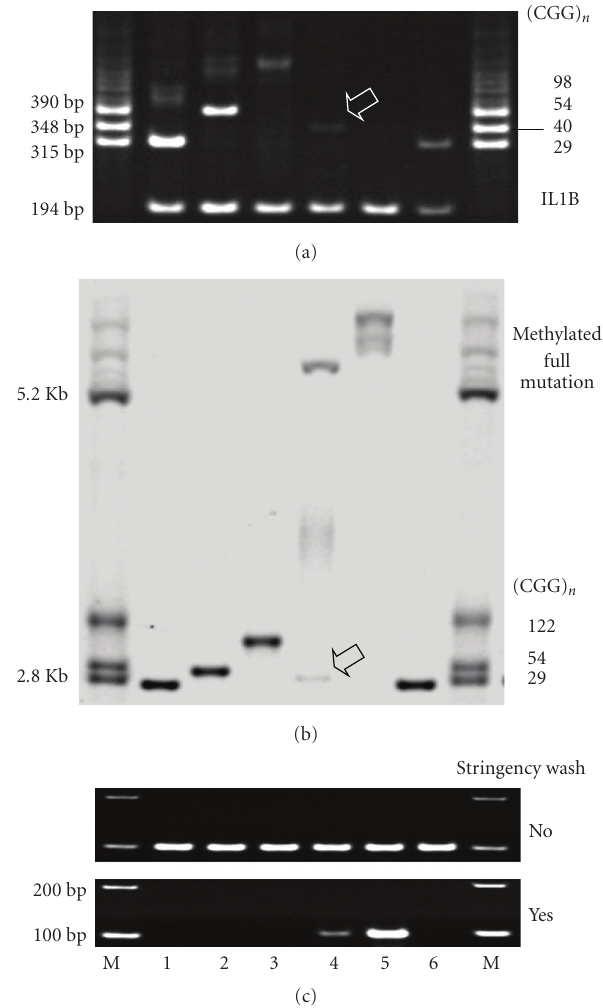
Figure 5: Representative males examined with (a) screening PCR, (b) Southern blot hybridization, and (c) methyl-CpG-binding PCR. For the non-FXS samples, the CGG repeat numbers are 29 (lanes 1 and 6), 54 (lane 2), and 98 (lane 3). For the FXS samples, lane 4 is a mosaic pattern comprising expanded FMR1 alleles with and without methylation, and unmethylated alleles with CGG-repeats in the normal range (indicated by arrows), and lane 5 has a nonmosaic pattern. (M): molecular size